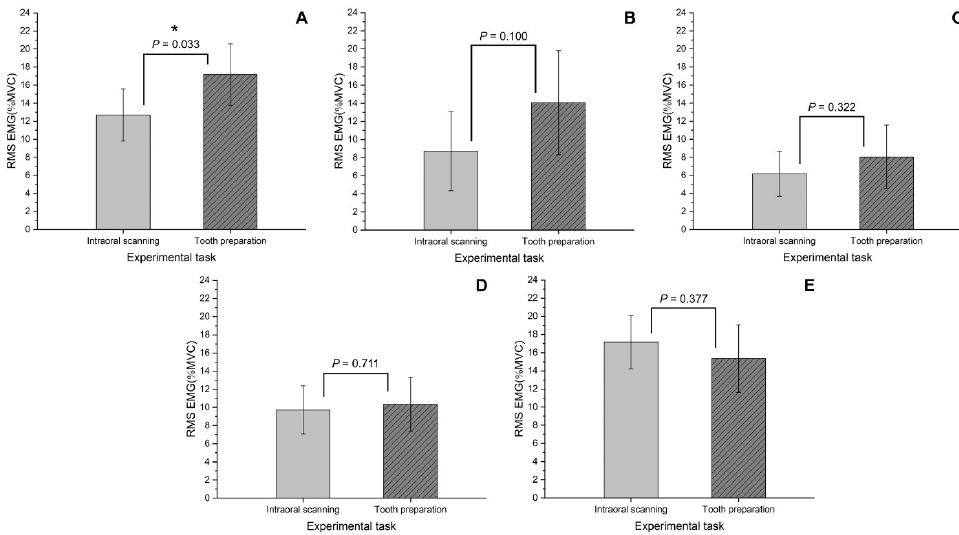
Figure 3. Comparison of RMS EMG (%MVC) according to the experimental task. ( A ) extensor digitorum communis; ( B ) flexor digitorum superficialis; ( C ) sternocleidomastoid muscle; ( D ) splenius capitis; ( E ) trapezius descendens.